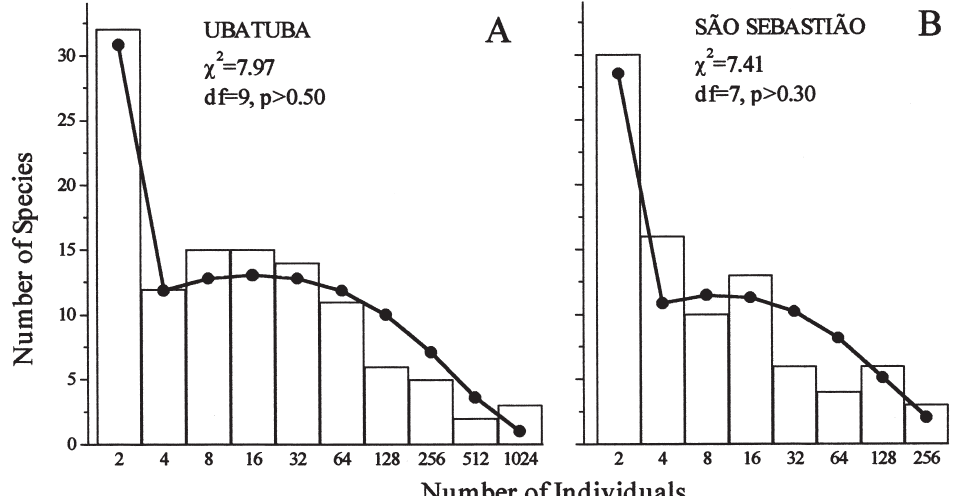
IG . 2. – Species distribution of the fauna associated with Schizoporella at (A) Ubatuba and (B) São Sebastião: observed (bars) and expected (lines) abundance of species following a log series